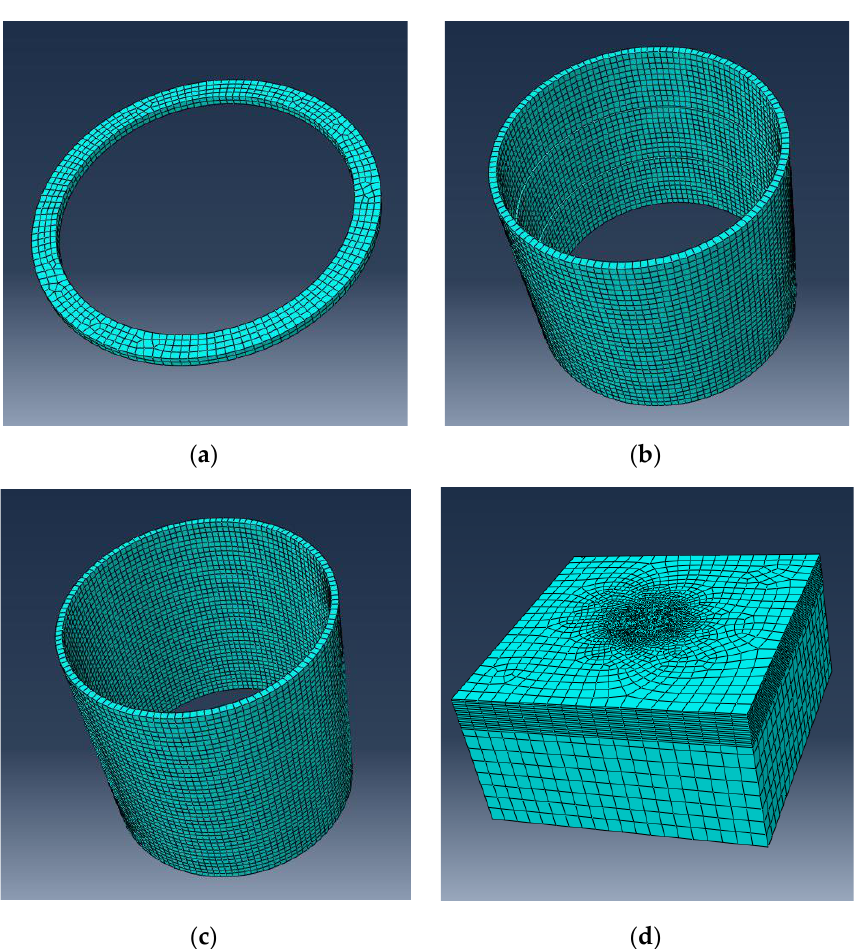
Figure 5. Three-dimensional continuum finite element mesh models. ( a ) Cap beam. ( b ) Lining. ( c ) Circular diaphragm wall. ( d ) Soil.